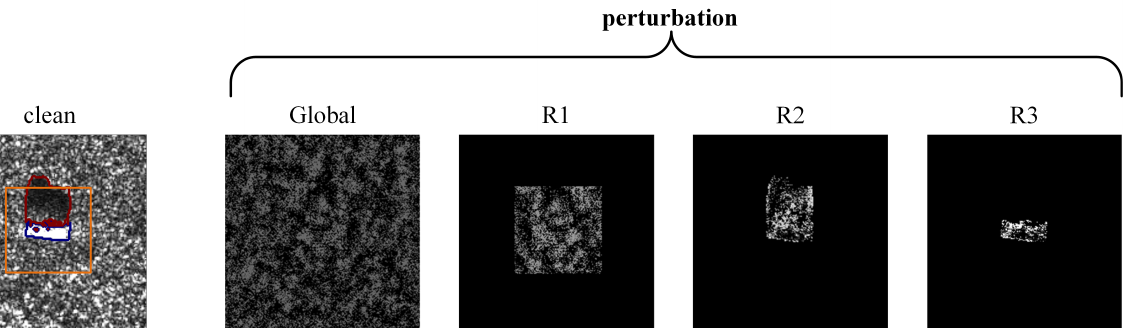
Figure 1. Illustration of region-constrained perturbation. Global, no constraint to the perturbation region. R1, constrain the perturbation to a 64 × 64-size candidate box (orange) that contains the target. R2, constrain the perturbation to the target region (blue) and the shadow region (red). R3, constrain the perturbation to the target region (blue).